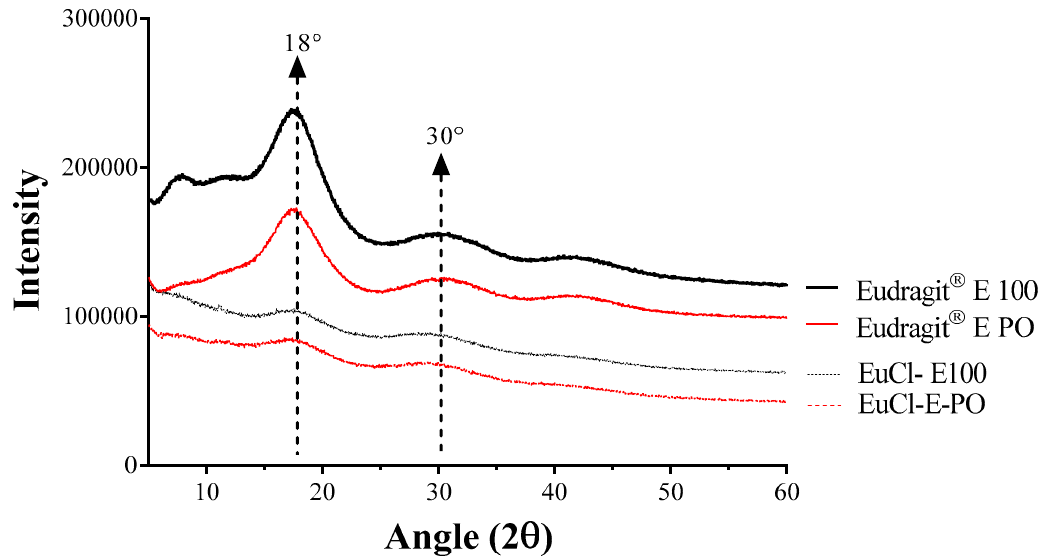
Figure 4. X-ray powder diffractograms of polymers derived from Eudragit® E.